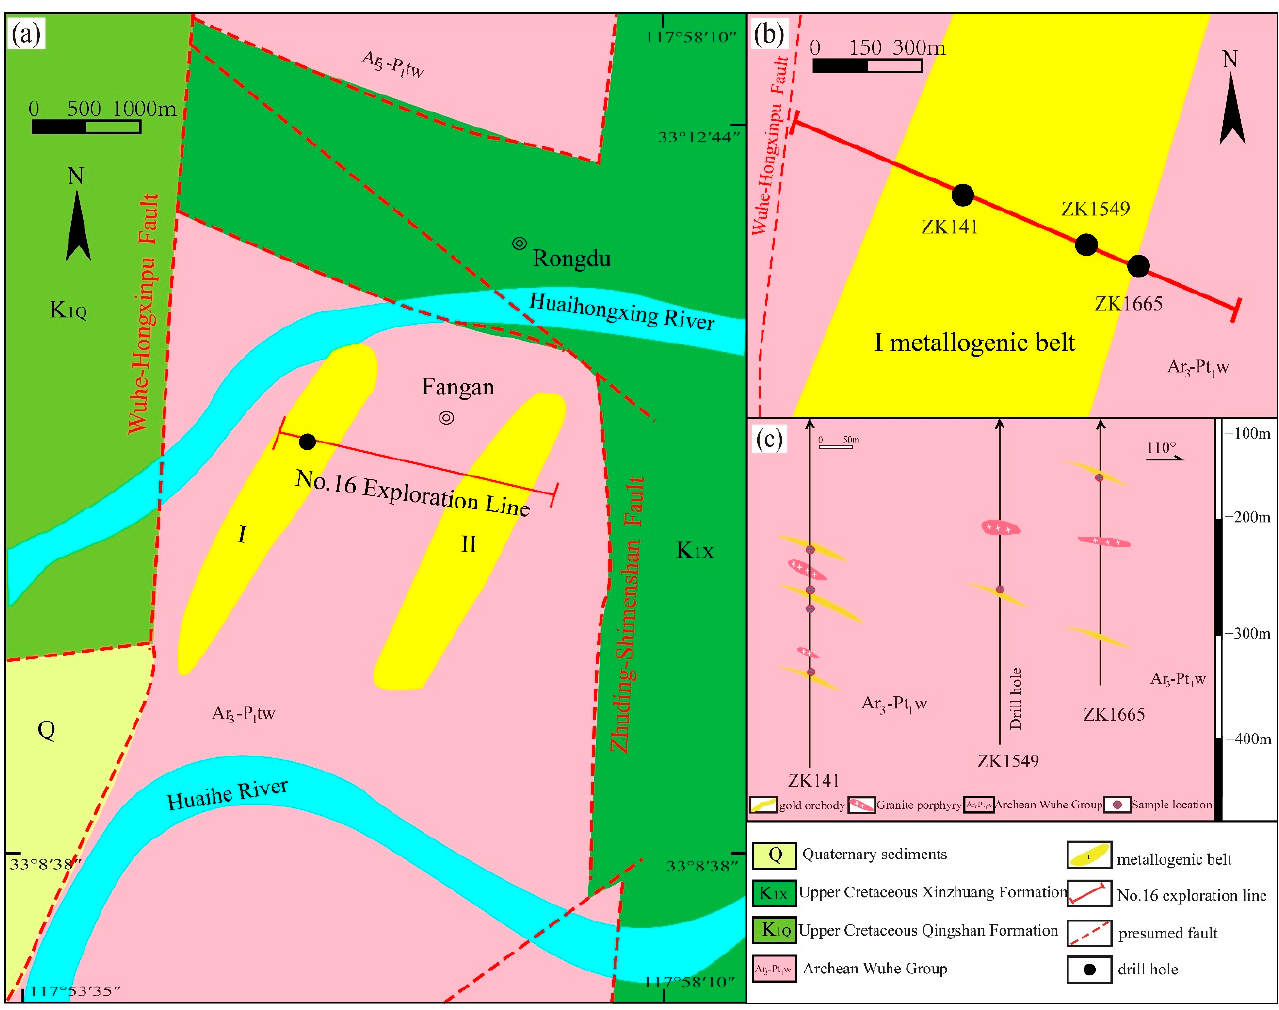
Figure 2. ( a ) Map of metallogenic belt distribution of Fang’an gold deposit, modified after [16]; ( b ) location of sampled drill holes projected onto the I metallogenic belt; ( c ) cross-section of No.16 exploration line in the Fang’an gold deposit, modified after [16] and No.312 Unit of Bureau of Geology and Mineral Exploration of Anhui Province.